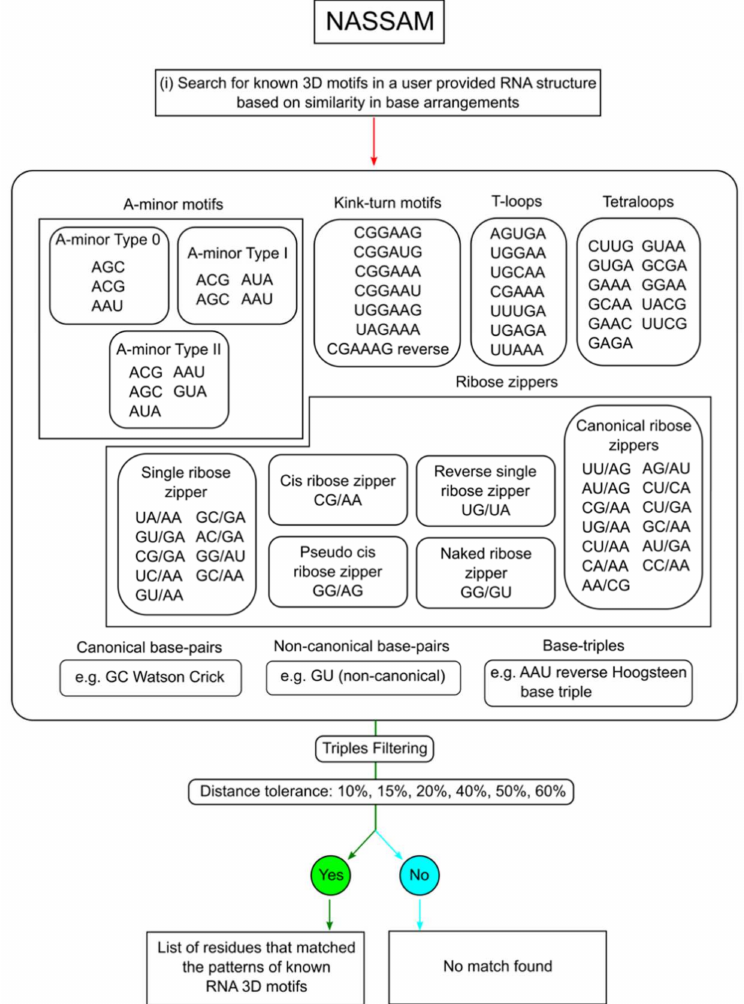
Figure 2. A flowchart outlining the search process for base arrangements in RNA structures that exhibit similar 3D geometry with known RNA base arrangements, performed by the NASSAM